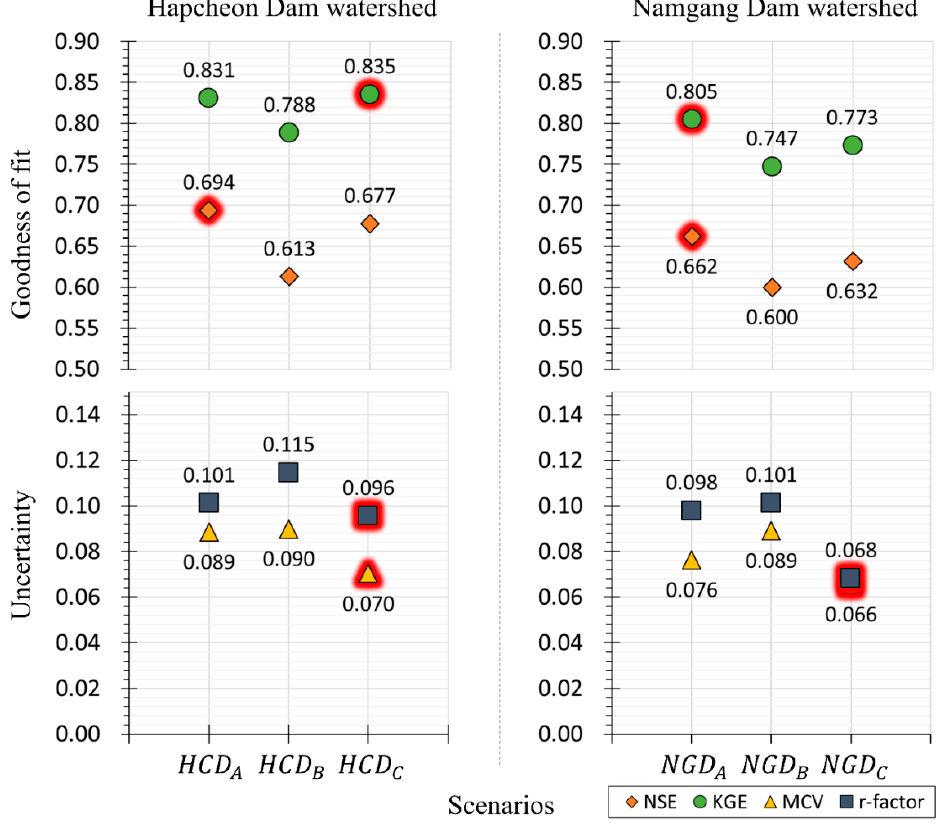
Figure 8. Goodness-of-fit (NSE and KGE) and uncertainty (MCV and r-factor) of daily stream flow simulated by each calibration scenarios for validation period (2012–2015). A highlighted symbol indicates the scenario that show best performance for each metric.